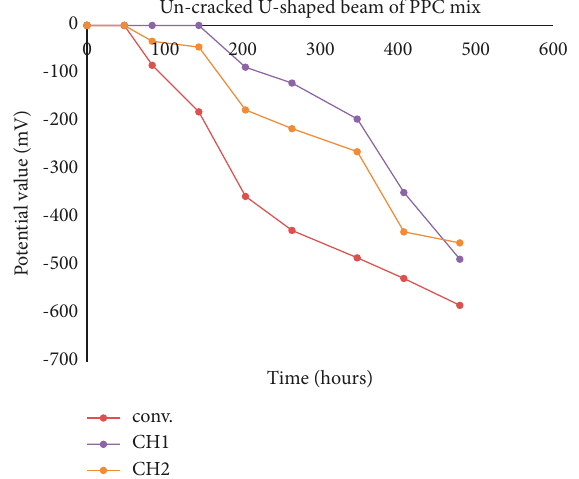
Figure 12: Uncracked U-shaped beam of PPC